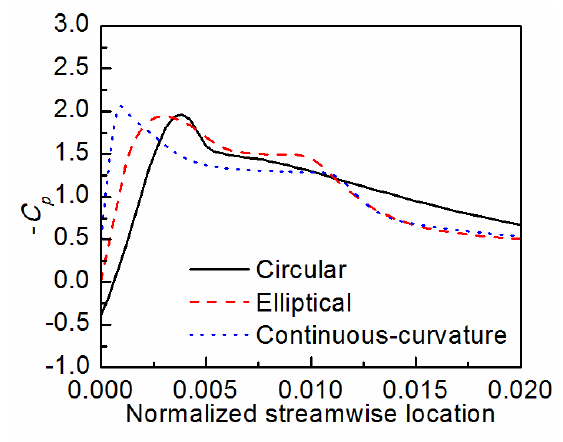
Figure 15. Pressure distributions at α = 60°.